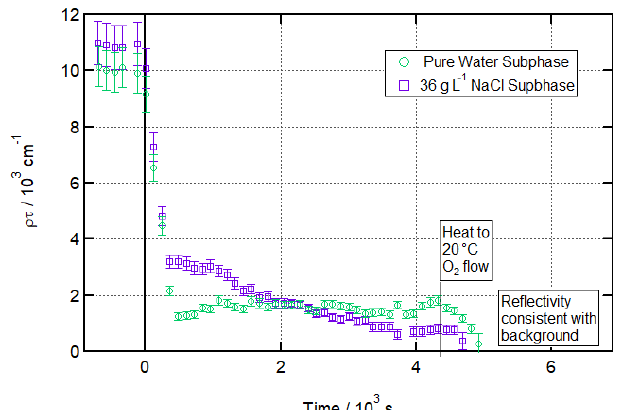
Figure 2. Ozonolysis of an oleic acid monolayer at low tempera- tures floating on pure vs. salt water. Time evolution plot for ozonol- ysis of 25µL 1.0gL − 1 d 34 -OA (CHCl 3 spreading solution) on pure water (green circles) and 36gL − 1 NaCl(aq) (purple squares) sub- phases by 323 ± 29ppb O 3 introduced at t = 0s at 3 ± 1 ◦ C (pure water) or − 2 ± 1 ◦ C (salt water).